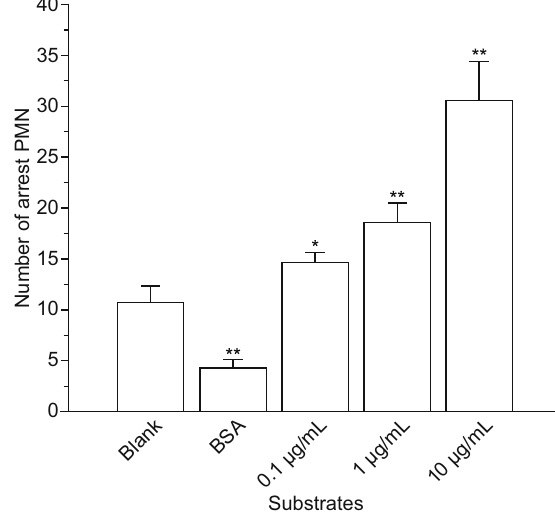
Figure 1. Number of fi rmly adhered neutrophils on substrates with various treatments in fl ow. The sub- strate was untreated, coated with BSA only, or coated with BSA or plus P-selectin (0.1, 1, or 10 μ g/mL). The data represent the mean ± (standard error of mean, SEM) from 3 independent experiments at a wall shear stress of 0.2 Pa. The signi fi cant level of difference from the untreated substrate group is shown by P -value, * for P < 0.05 and ** for P <